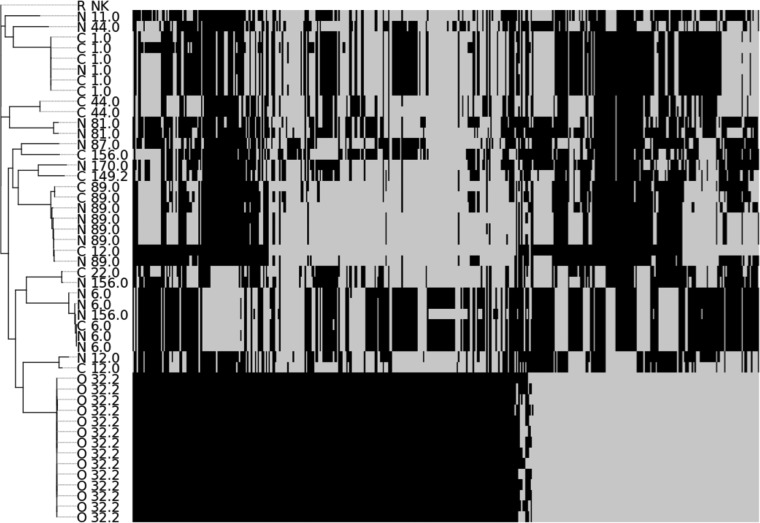
Maximum likelihood phylogeny of the 48 GAS isolates based on core genome SNPs. Each branch is annotated with the isolate source followed by the in silico emm type. R, the GAS reference sequence Streptococcus pyogenes HKU16; C, control iGAS cases; N, control noninvasive isolates; and O, outbreak emm32.2 iGAS cases. (Right) The absence (gray) or presence (black) of accessory genes in each strain in no particular order. An expanded version of this figure, showing the gene names is presented in Table S1 in the supplemental material.